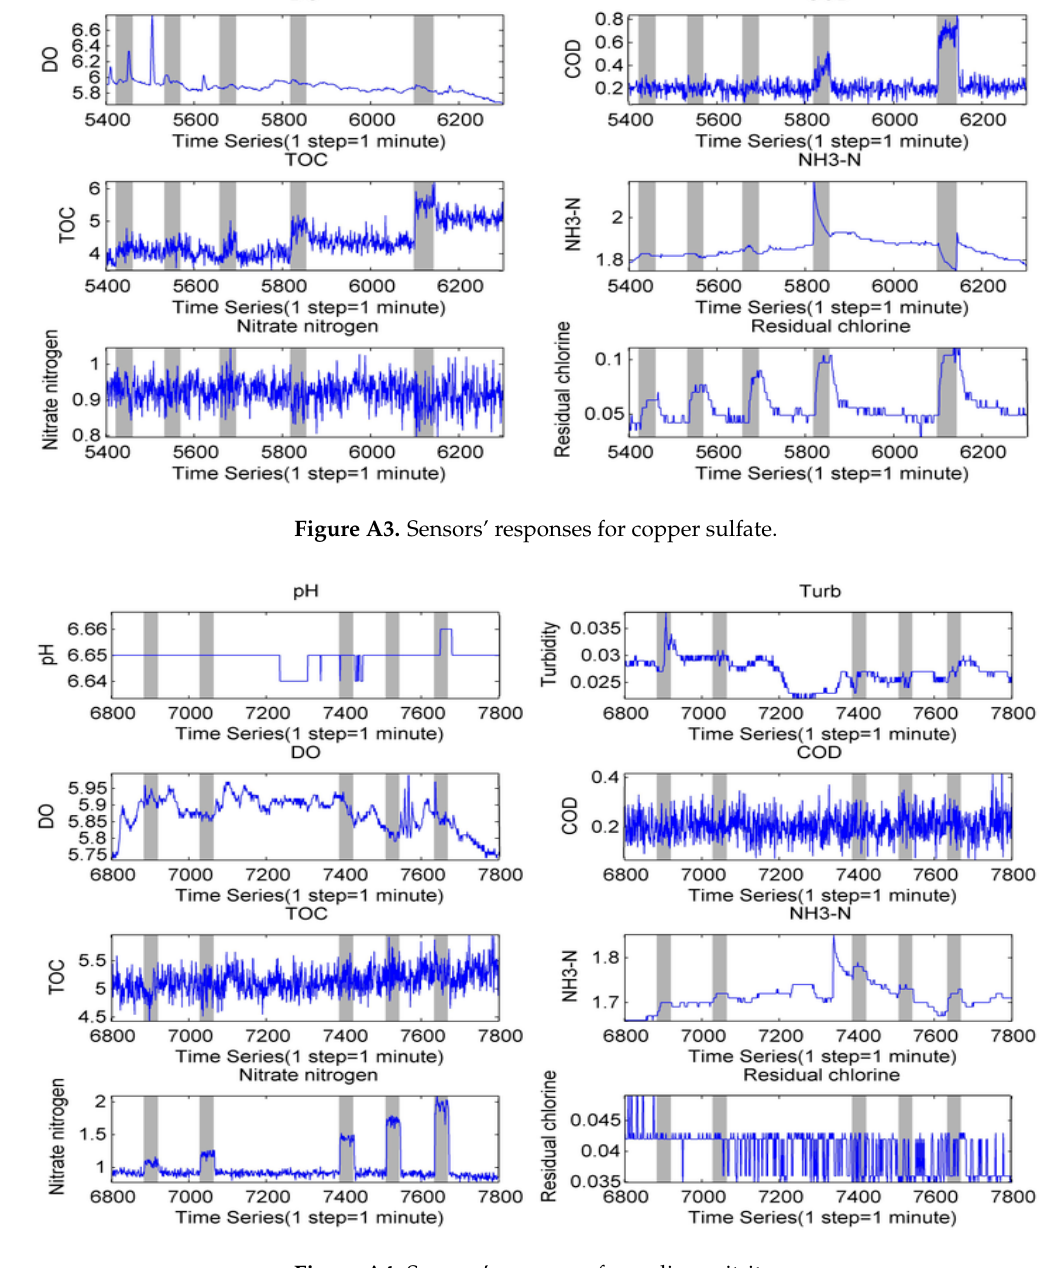
Figure A4. Sensors’ responses for sodium nitrite.